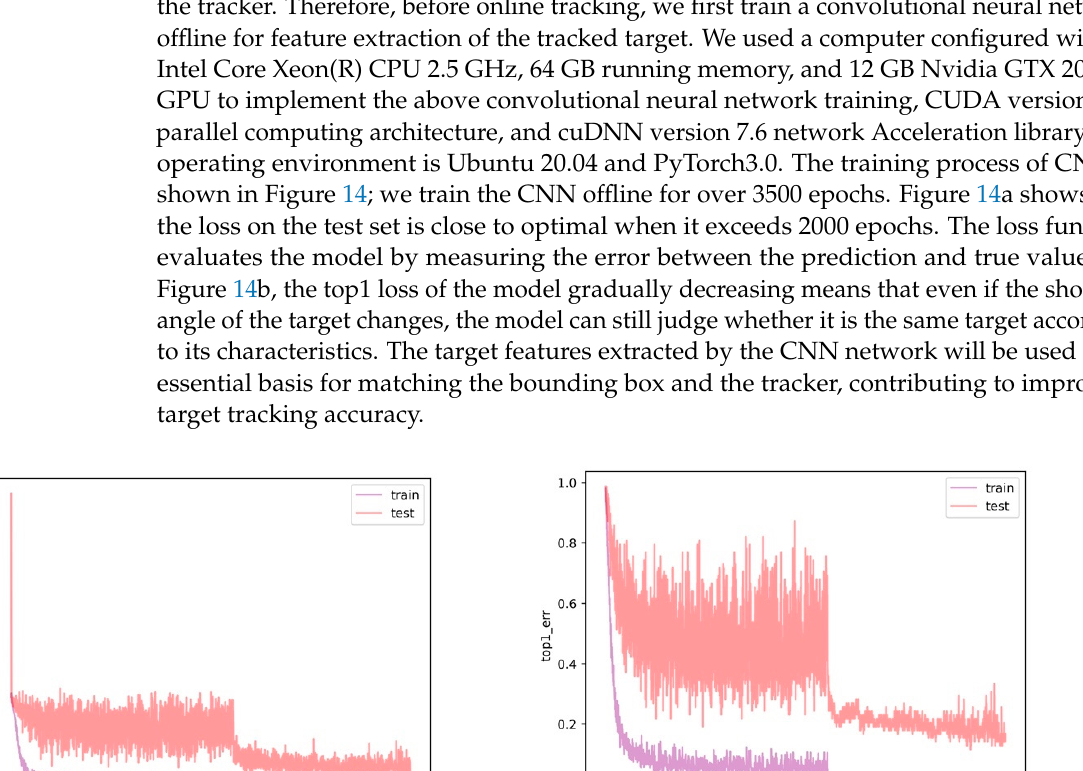
Table 4. The detection results of a series of YOLO networks and YOLO-deepsort. Model Precision Recall